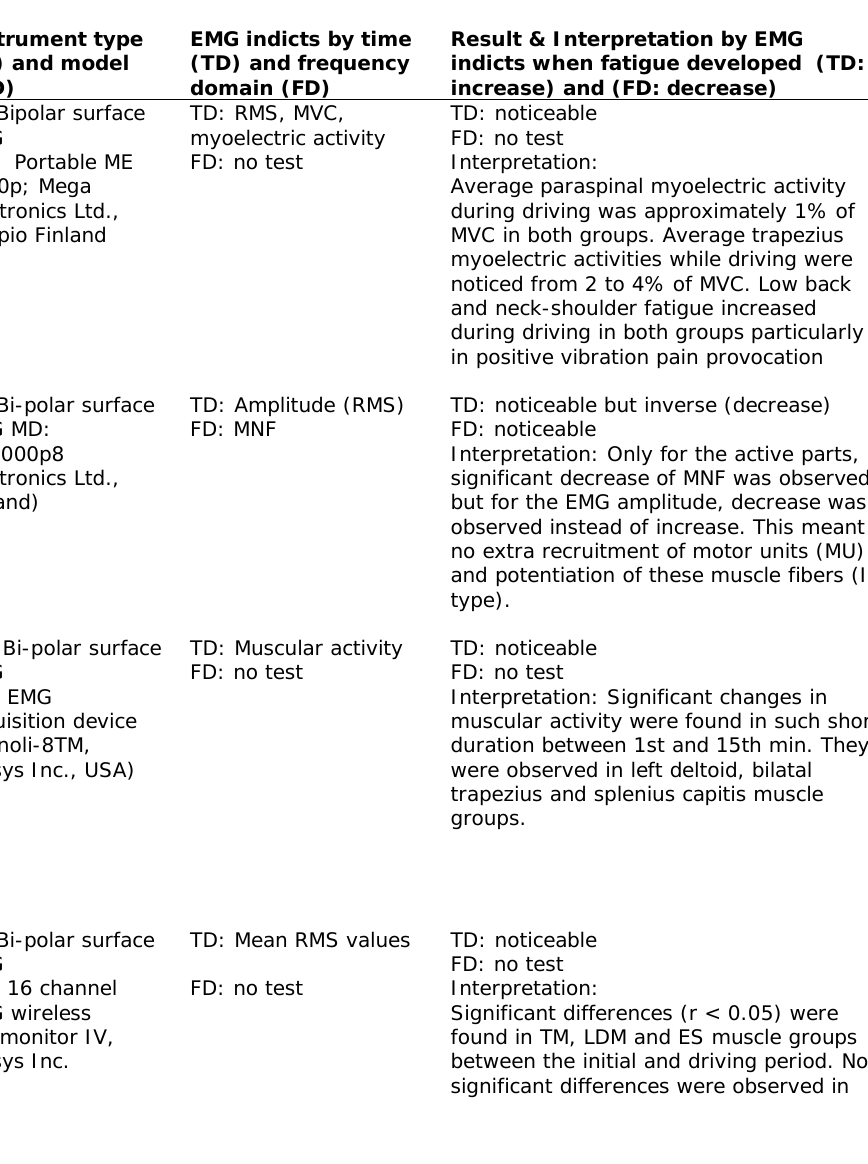
Table 1. Studies of land transportation/transshipment associated vehicles (9 studies)